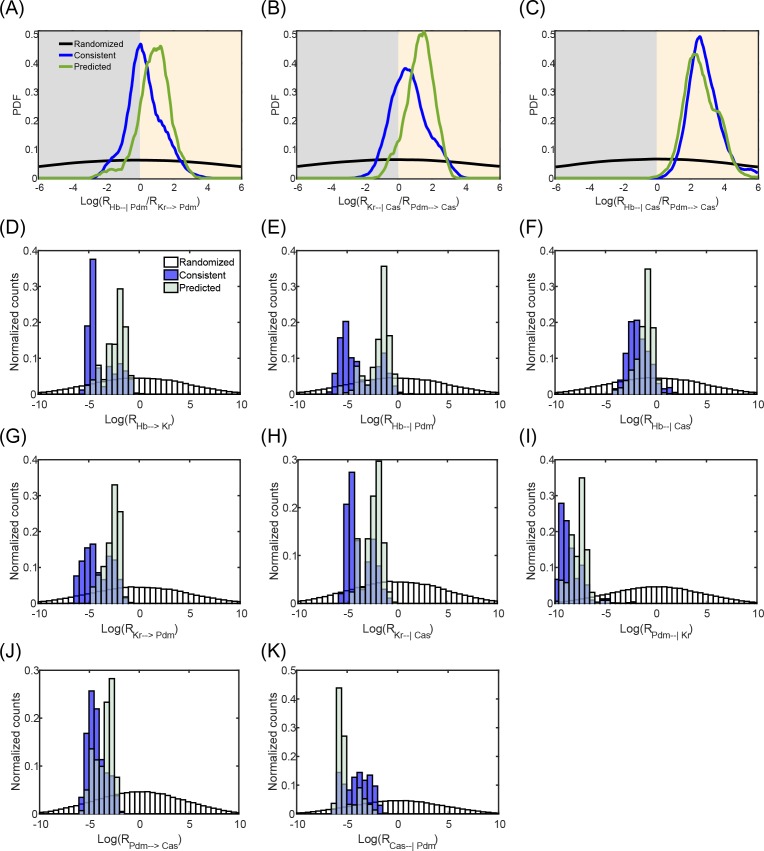
Predicted model parameter values.For each of the eight regulations in the model, from TTF i to TTF j, the following unit-less quantity was defined: the ratio between total production rate βi of the regulating TTF and degradation rate αi multiplied by the regulation coefficient Ki,j (Supplementary file 1): Ri,j=βiαi*Ki,j. The greater this ratio, the faster TTF i will surpass the appropriate threshold and perform its regulatory role on TTF j. Therefore, Ri,j can be viewed as the 'strength' of the regulation of TTF j by TTF i. Since absolute parameter values may be rescaled between circuits which will then exhibit similar behavior, this ratio better captures the regulations in the model. We further define three groups of parameter sets (circuits).1. Randomized: randomly drawn parameter sets (both consistent and inconsistent, see Materials and methods, Supplementary file 1,3).2. Consistent: all consistent circuits, as described in Figures 1–2.3. Predicted: consistent circuits which are still consistent with our new measurements (Figure 5A–F) and are robust. These circuits are found in Decay-Relay space at the intersection between the area defined by our measurements and the robust zone (Figure 5I: significance of decay network 65–80%, significance of relay network <30%).In order to compare the relative strength of two interactions governing TTF j within the circuits (a decay interaction by TTF i and a relay interaction by TTF k), we calculate log⁡(Ri,jRk,j). Note that it is only meaningful to compare interaction governing the same event: the upregulation of TTF j or the downregulation of TTF j. (A-C) We then plot the Probability Density Function (PDF) of log⁡(Ri,jRk,j) for each of the three circuit groups described above, subtracting the mean of the Randomized PDF from all 3 PDFs. Values below 0 indicate Rk,j, the relay interaction is 'stronger' while values above 0 indicate Ri,j, the decay interaction is 'stronger'. In all three interaction pairs examined, for consistent and predicted circuits, the PDF is asymmetrical around 0 and is spread out more to the right. This indicates decay dominance for most circuits in these groups. In (A) and (B), this phenomenon is stronger for the predicted PDF than the consistent PDF. Therefore, the predicted circuits are more decay dominated than the consistent circuits. (D-K) On the same plot, normalized histograms of log(Ri,j) (i,j indicated in X axis label), for the three groups of circuits mentioned above, color coded as indicated in the legend of panel D. Consistent parameter sets are a subset of randomized parameter sets; predicted parameter sets further restrict parameter values.